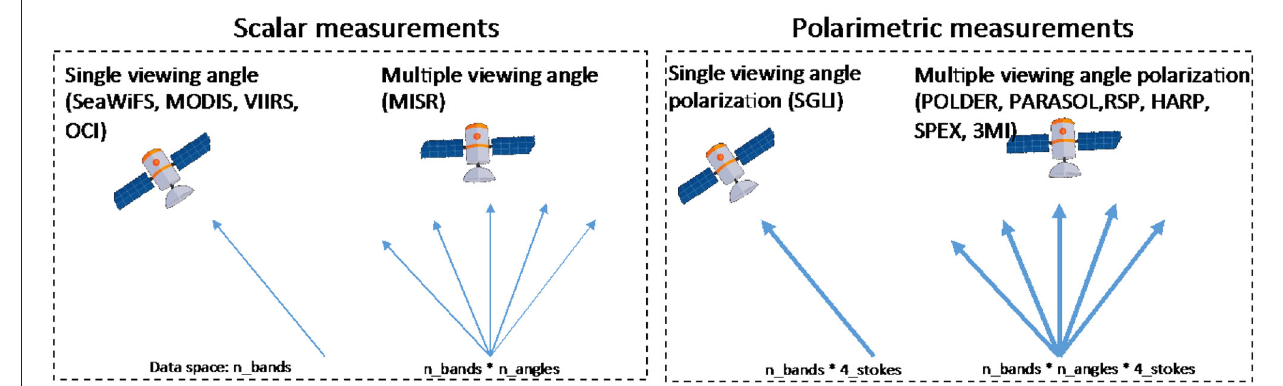
FIGURE 9 | Observing system configurations of scalar and polarimetric measurements at single and multiple viewing geometries. The data space indicates the increased dimension of multi-angular polarimeters from single view radiometers as a proxy to the information content of the measurements.